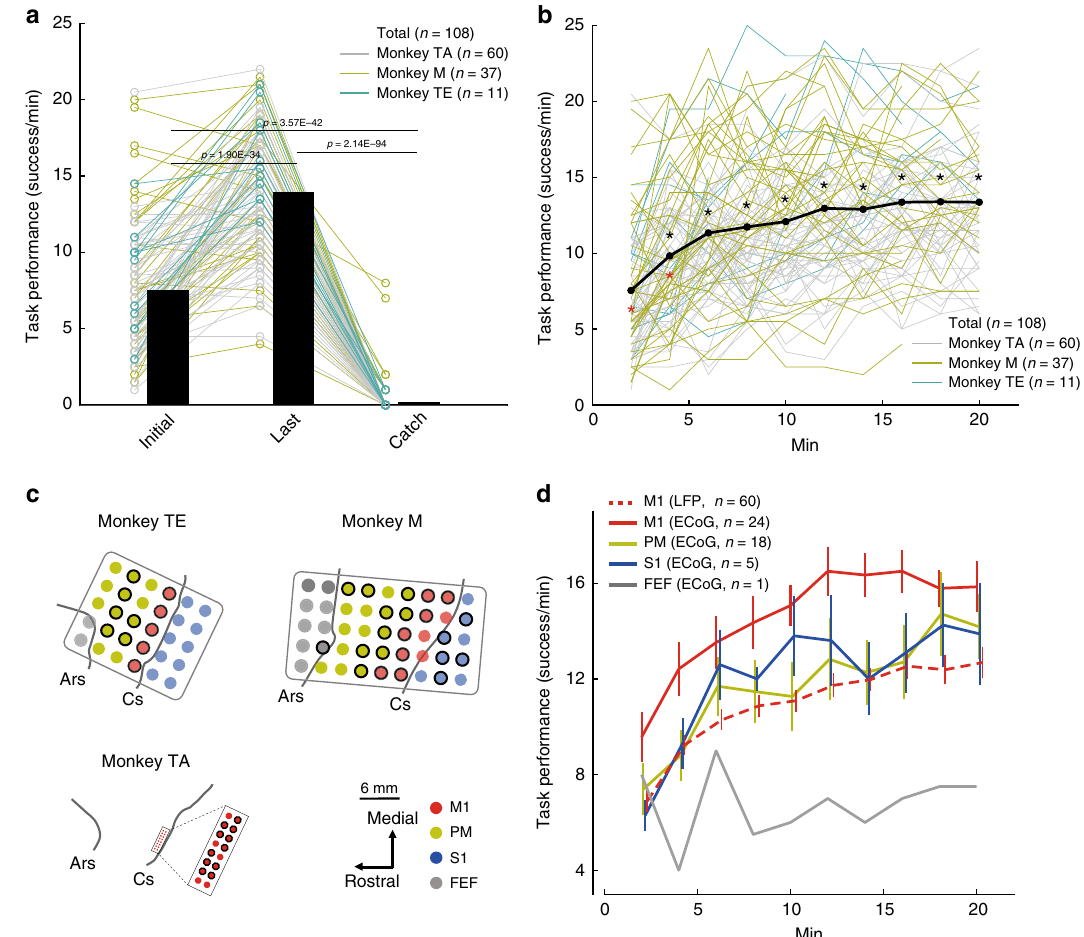
Fig. 2 Task performance improves with practice. a Task performance during the initial and last 2 min of a session and during the catch trials ( N = 3 monkeys, n = 108 ACMC sessions, consisting of 72 torque-matching and 36 position-matching task sessions; Monkey TA, n = 60 sessions; Monkey M, n = 37 sessions; Monkey TE, n = 11 sessions). Bars indicate mean values and circles indicate individual data points. b Time course of averaged task performance across 108 sessions in the three monkeys; Black dots show mean values; thin lines represent individual sessions. Black and red asterisks represent signi fi cant differences ( P < 0.05 by one-way ANOVA with Bonferroni ’ s correction for post hoc multiple comparisons) compared to the initial and last 2 min of the session, respectively. c Electrode locations. In Monkeys TE and M, the electrocorticography (ECoG) electrode array was placed on the surface of the frontal eye fi eld (FEF; grey), premotor cortex (PM; yellow), primary motor cortex (M1; red), and primary somatosensory cortex (S1; blue). In Monkey TA, 16 microelectrodes were implanted within the hand area of M1 (red dots). The electrodes that were used as the input signal for the ACMC are encircled in black. Ars: arcuate sulcus, CS: central sulcus. d Time course of task performance using the ACMC with input electrodes in the FEF (grey line, n = 1 session in Monkey M), PM (yellow line, n = 18 sessions in Monkey TE and M), M1 with ECoG array (red solid line, n = 24 sessions in Monkey TE and M), M1 with microelectrode array (dashed red line, n = 60 sessions in Monkey TA), and S1 (blue line, n = 5 sessions in Monkey M). Task performance of M1 electrodes with ECoG array was signi fi cantly higher than that with the other areas, and task performance with FEF electrode was signi fi cantly lower than that with the other areas ( P < 0.05 by two-way ANOVA with Bonferroni ’ s correction for Post hoc multiple comparisons). Detailed statistical results for ( b ), ( d ) are shown in the source data. Data in ( d ) are shown as means and standard